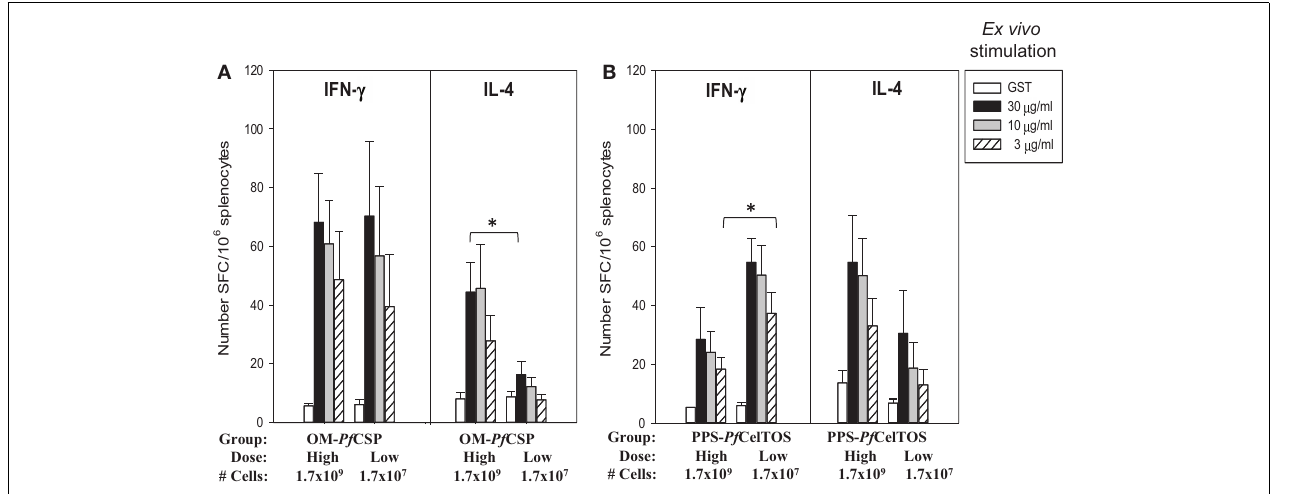
control). Data are expressed as the mean and standard error from the mean (SEM) number of spot-forming cells (SFC) from n = 5 mice/group. Mice were immunized with either High dose = 1.7 × 10 9 or Low dose = 1.7 × 10 7 number of cells. Asterisk indicates statistical significance (Students T -test; * p <